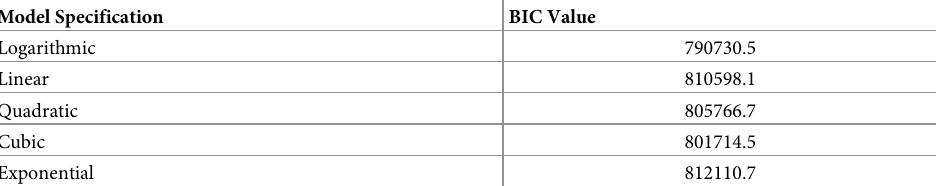
Table 2. Summary of model fit on all subjects for 5 latent classes across all model